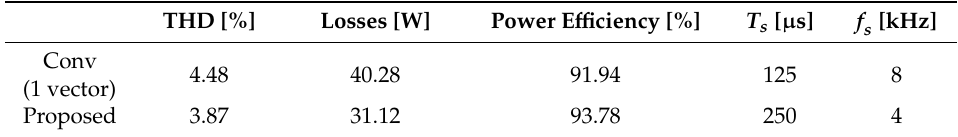
Table 3. Performance comparison between the conventional method and the proposed method in simulation results.